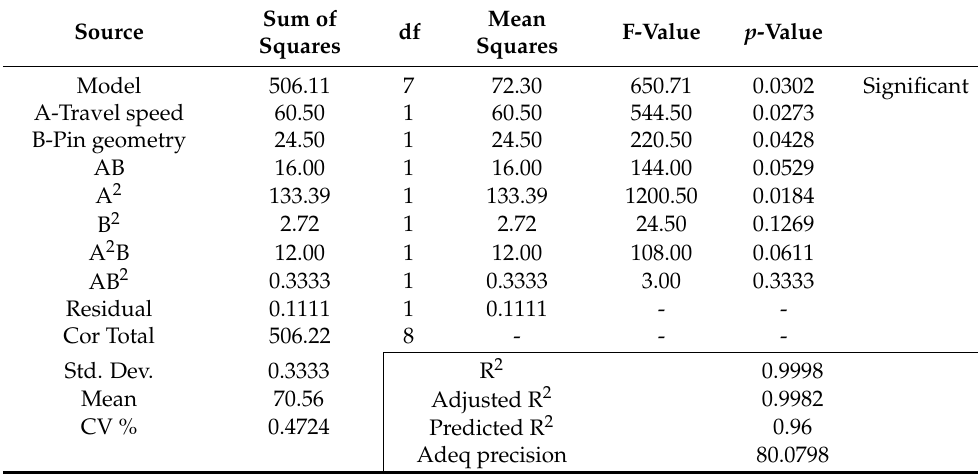
Table 8. ANOVA for UTS of AA1050 BT-FSP